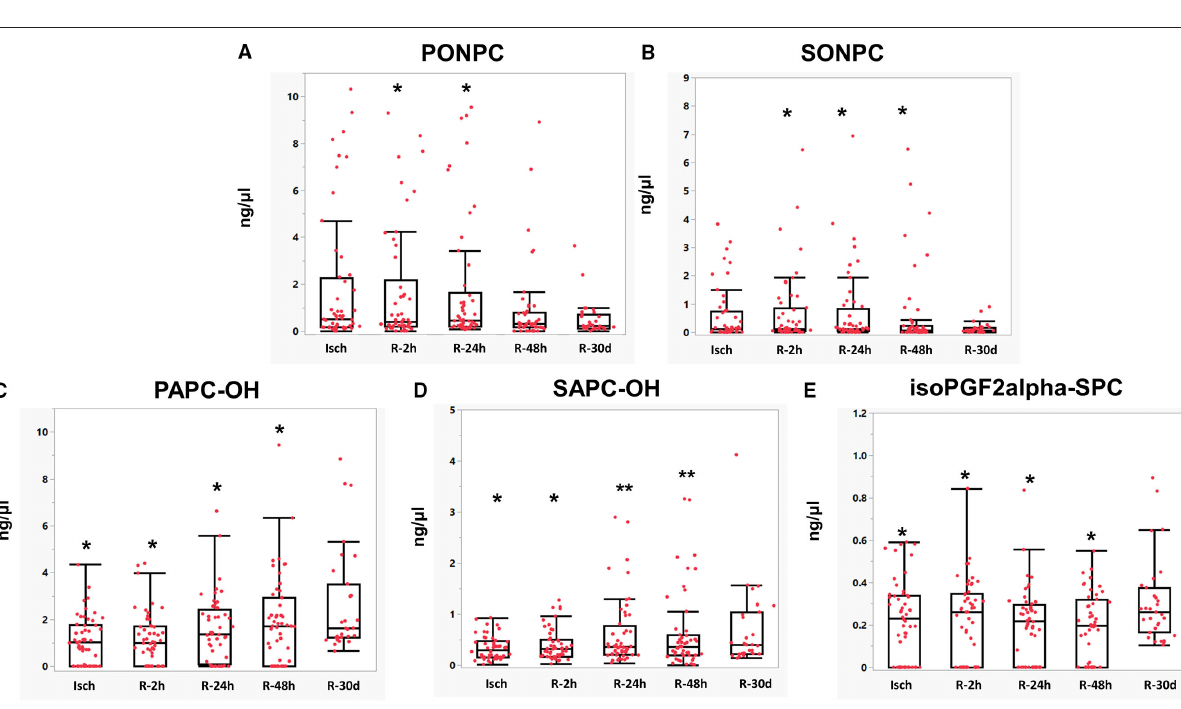
23% of total OxPC levels in thrombus ( Figure 8 ). PONPC and POVPC were the two most abundant OxPC in STEMI